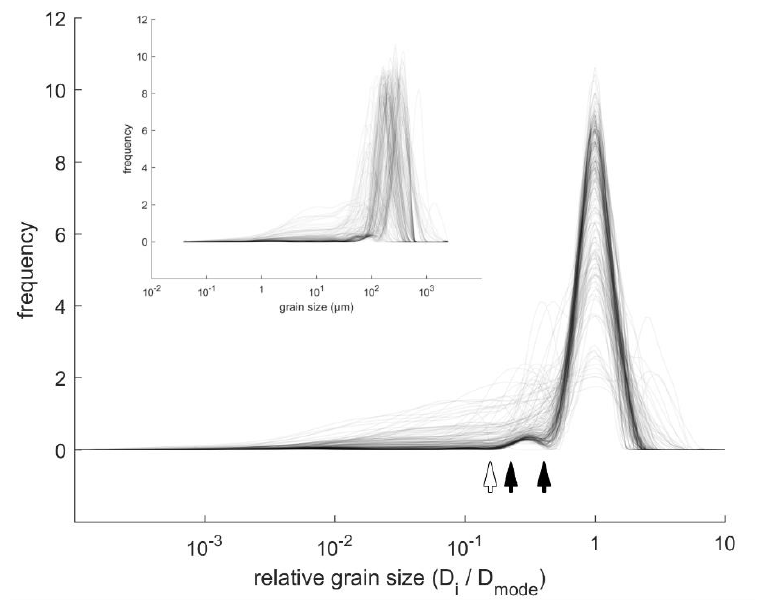
Figure 3. Distribution of relative grain sizes. The dominant modal grain size equals unity. N = 200 distributions (HE-411, 412, 432, 447). Individual distributions are plotted semi-transparent for improved readability; the tone is darker where multiple lines overlap. The white arrow indicates the non-dimensional size of pore throats; the black arrows indicate void radii for tetrahedral and hexahedral packing. The dimensional (raw) grain size distributions are shown in the insert.